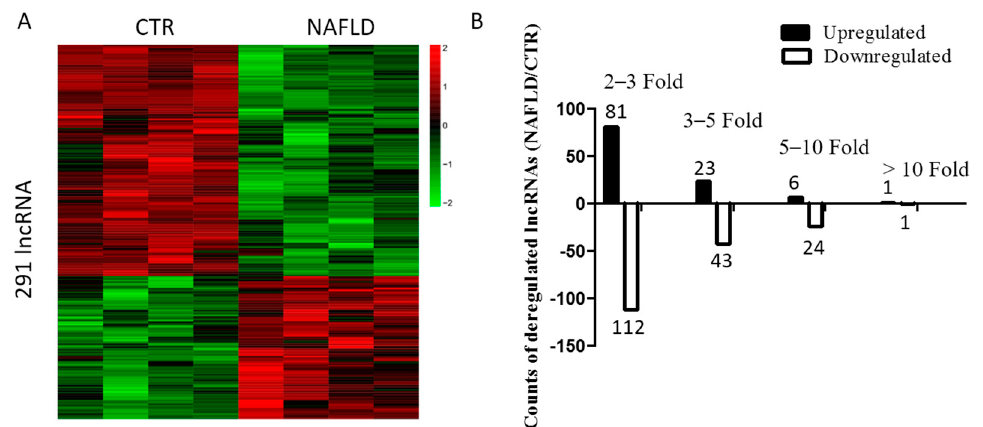
Figure 1. Long non-coding RNAs (lncRNA) profile in non-alcoholic fatty liver disease (NAFLD). ( A ) Heat map of differentially expressed lncRNAs in control (CTR) and NAFLD mice. Each row shows relative expression levels of a single lncRNA and each column represents expression levels for a single sample. Relative high (red) or low (green) expression is indicated; ( B ) Expression profiling of lncRNAs in NAFLD and control mice. Up- or downregulated lncRNAs were defined as normalized probe signal intensity of lncRNAs that changed more than two-fold in NAFLD compared with control. Black bars represent the number of upregulated lncRNAs, whereas white bars represent the number of downregulated lncRNAs.